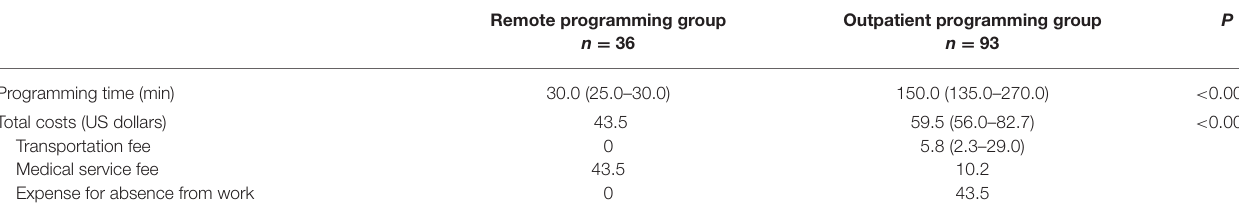
TABLE 3 | Expenditure and time-cost for each programming in the remote and outpatient programming